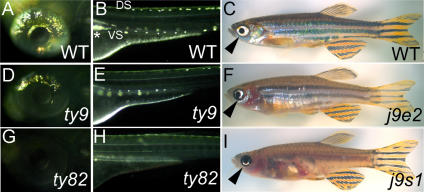

shady mutants form an allelic series with reduced iridophores.A, B, D, E, G, H) Incident light images of 72 hpf embryos to show eye (A, D, G) and posterior trunk (B, E, H) iridophores (silver spots) in embryonic alleles (D, E, shdty9, weaker; G, H, shdty82, strong) and WT siblings (A, B). C, F, I) Adult viable alleles (F, shdj9e2, weaker; I, shdj9s1, stronger; phenotypic severity shown most clearly by eye iridophores (arrowheads)) and WT sibling (C). In this and subsequent figures, embryos are shown in lateral view, except where noted. DS, dorsal stripe; VS, ventral stripe; *, Lateral patch.